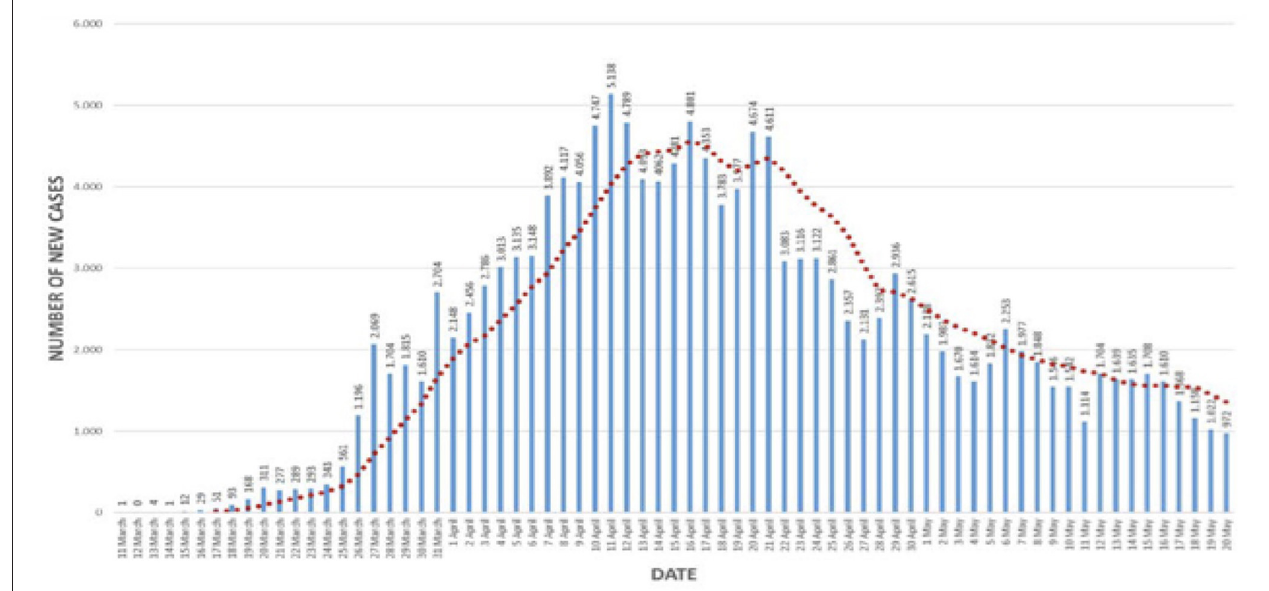
FIGURE 3 | The epidemiological curve of SARS-CoV-2 cases reported in Turkey. Source: Daily reporting from the Directorate General for Health Information Systems, Ministry of Health, Turkey